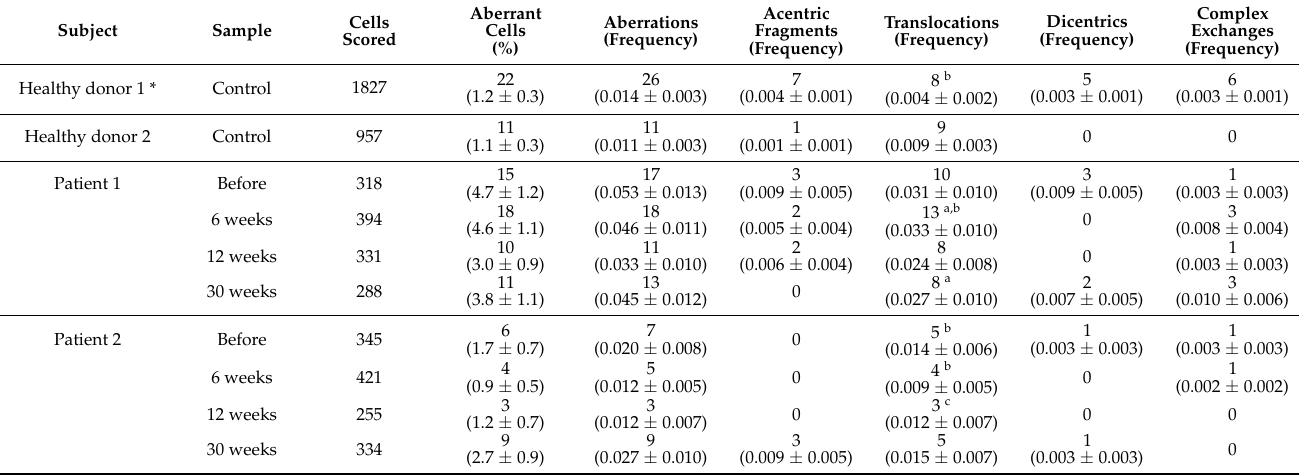
Table 1. Number of aberrant lymphocytes and the corresponding aberration types visualized by the multiplex fluorescence in situ hybridization (mFISH) technique measured in healthy donors and in patients at the indicated times before and after the onset of therapy (6–30